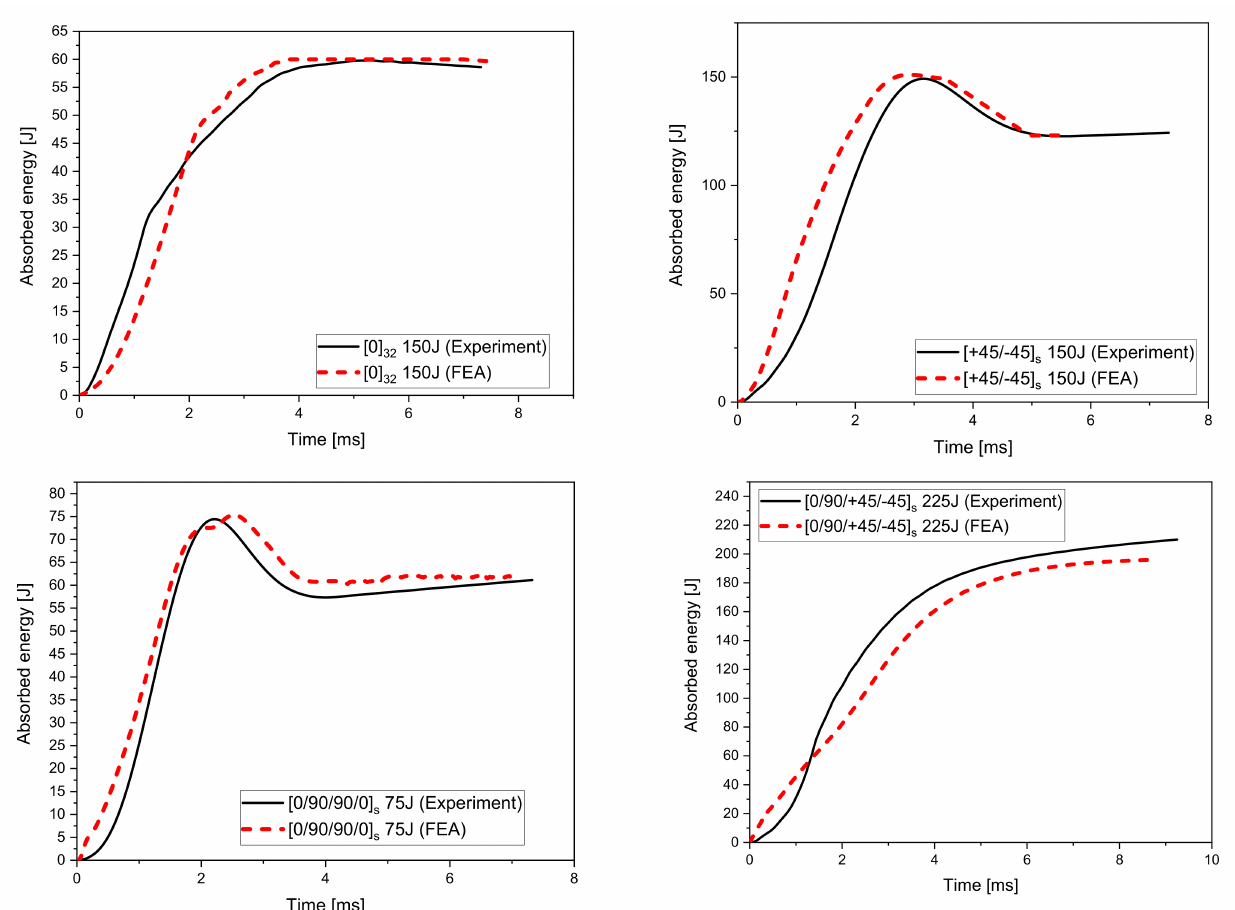
Figure 10. FE results for the absorbed energy vs. time curves for S2/FM94 glass fibre plates with different fibre orientation systems under 150 J impact